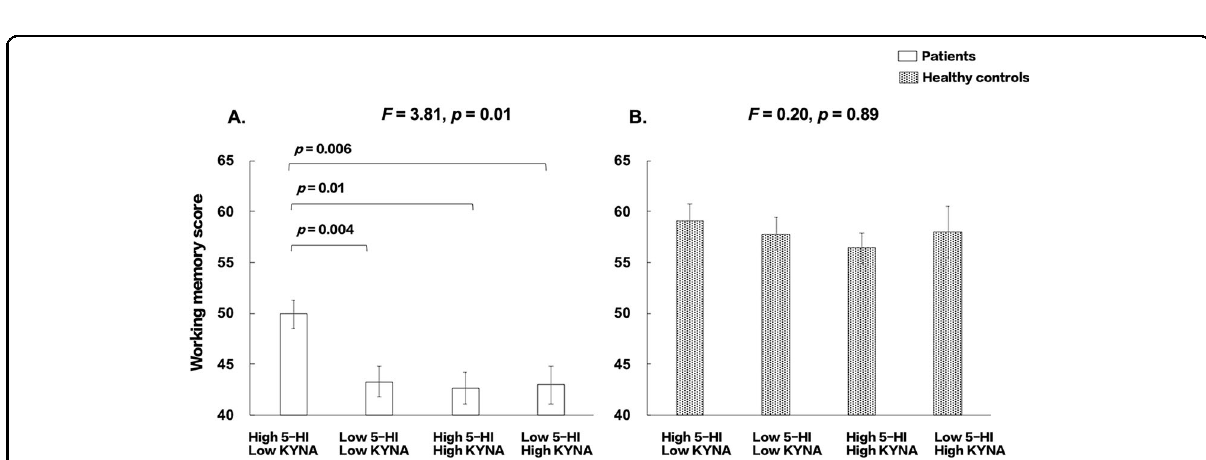
Fig. 3 Comparisons of working memory performance in subgroups with 5-HI and KYNA levels by medium splits adjusting for age and sex. A Patients with schizophrenia. B Healthy